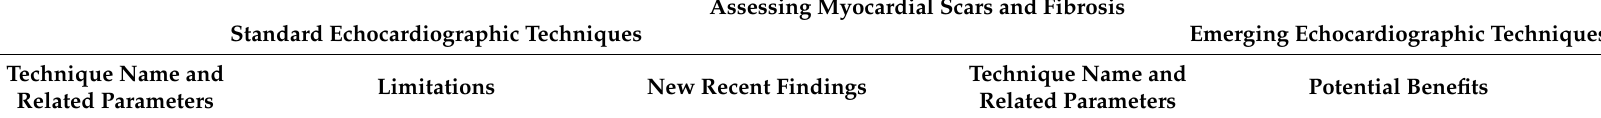
Table 7. Comparison between Standard and Emerging echocardiographic techniques to assess myocardial scars and fibrosis in dilated